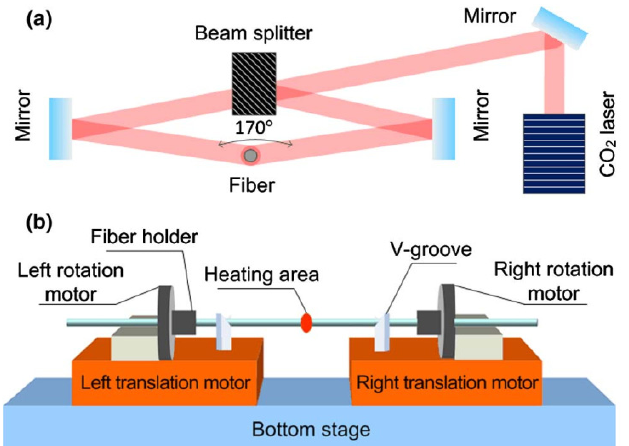
Figure 8. The commercial fusion splicer-based fabrication setup of the HLPG, where the fiber is heated by CO 2 laser beam at both sides of the fiber surface. ( a ) Optical path of the laser beam in the fusion splicer (Fujikura Inc. LZM-100). ( b ) Schematic diagram of the setup. Adapted with permission from Ref. [54] © The Optical Society.